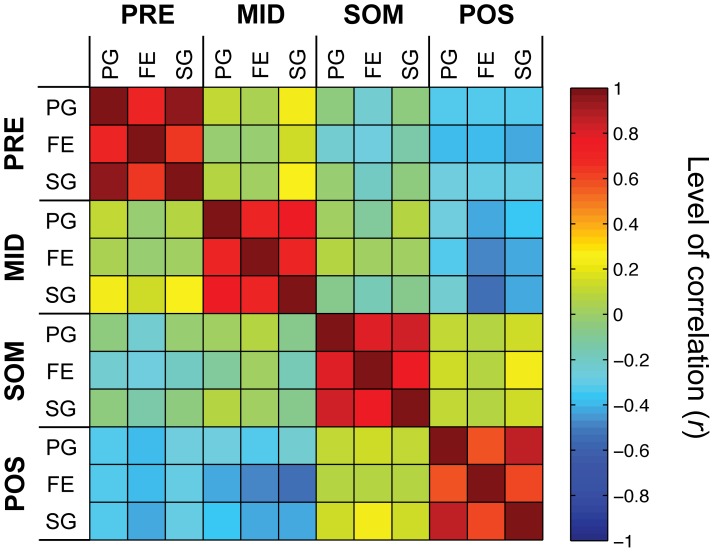
Correlation analysis of hand-manipulation-related activity of among somato-motor populations.Correlation among mean net normalized responses to each of the 3 grips (PG, FE and SG) in the 4 somato-motor types of neurons (PRE, MID, POS and SOM). The correlation map was reordered based on similarity of correlation values among types. Color code indicates correlation value (r) between all possible pair of responses.